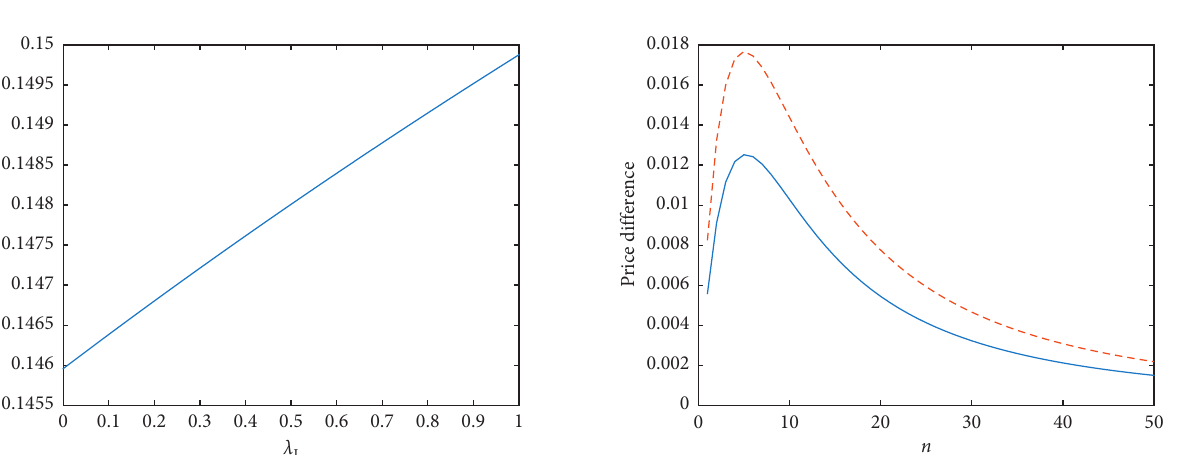
Figure 7: The CDS prices under different λ